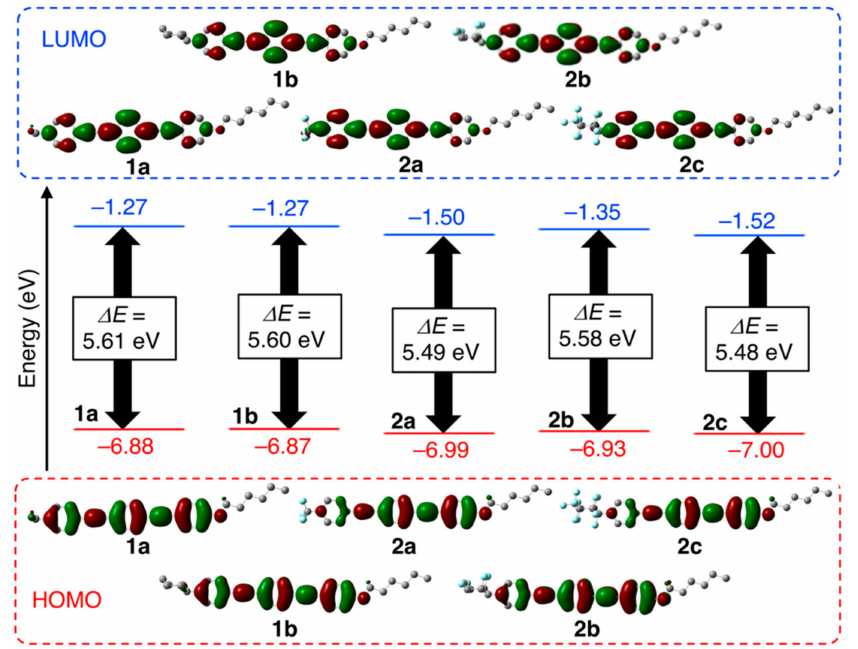
Figure 3. Molecular orbitals and orbital energies for bistolanes 1a and 1b (bearing an alkyl chain), and 2a – 2c (bearing a fluoroalkyl unit). In the MO diagrams, hydrogen atoms are omitted for clarity from the molecular